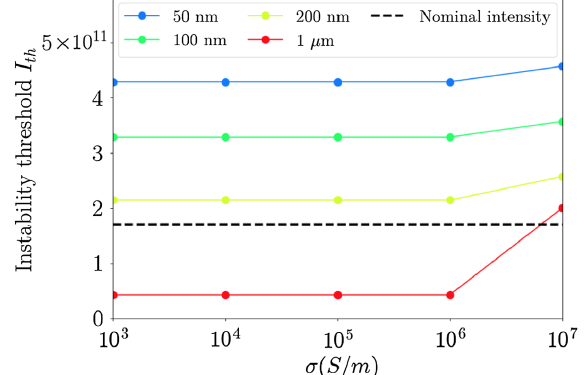
FIG. 5. MI threshold as a function of the coating conductivity for all thicknesses under study. The black dashed line corre- sponds to the nominal bunch intensity.